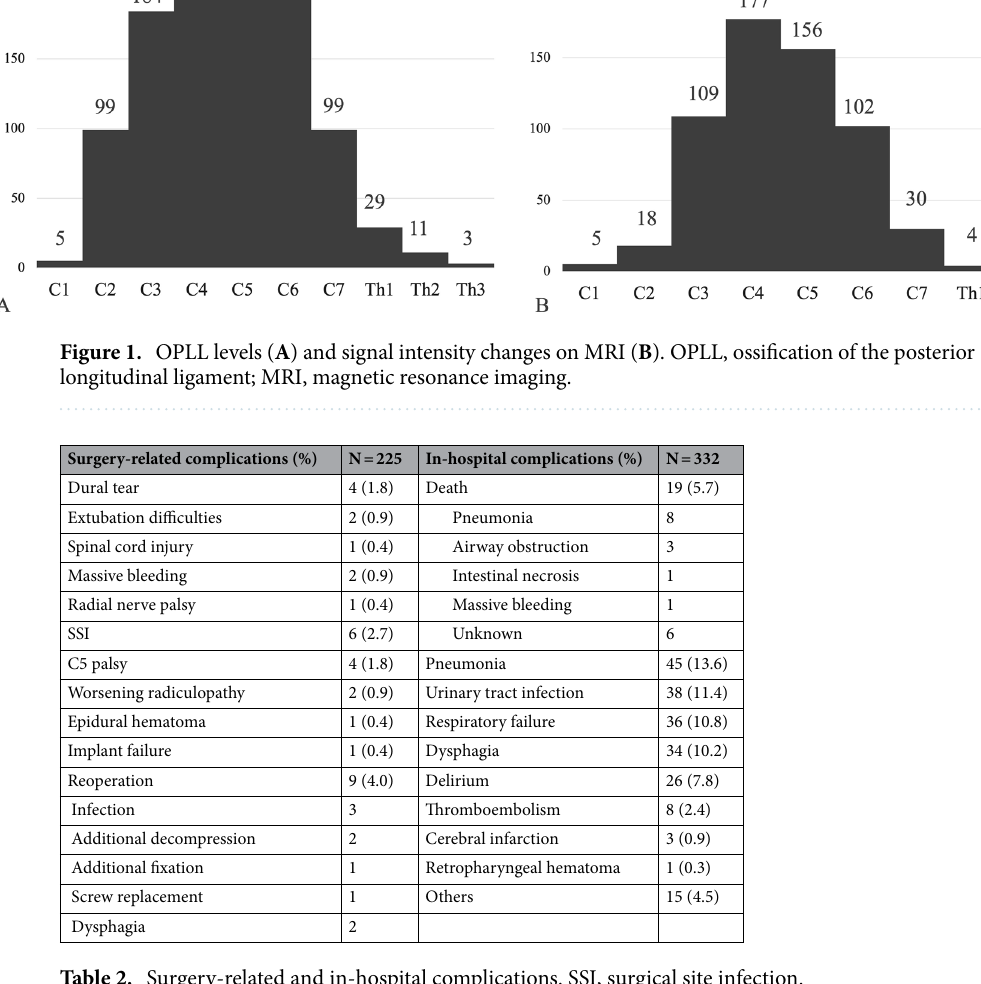
Table 2. Surgery-related and in-hospital complications. SSI, surgical site infection.